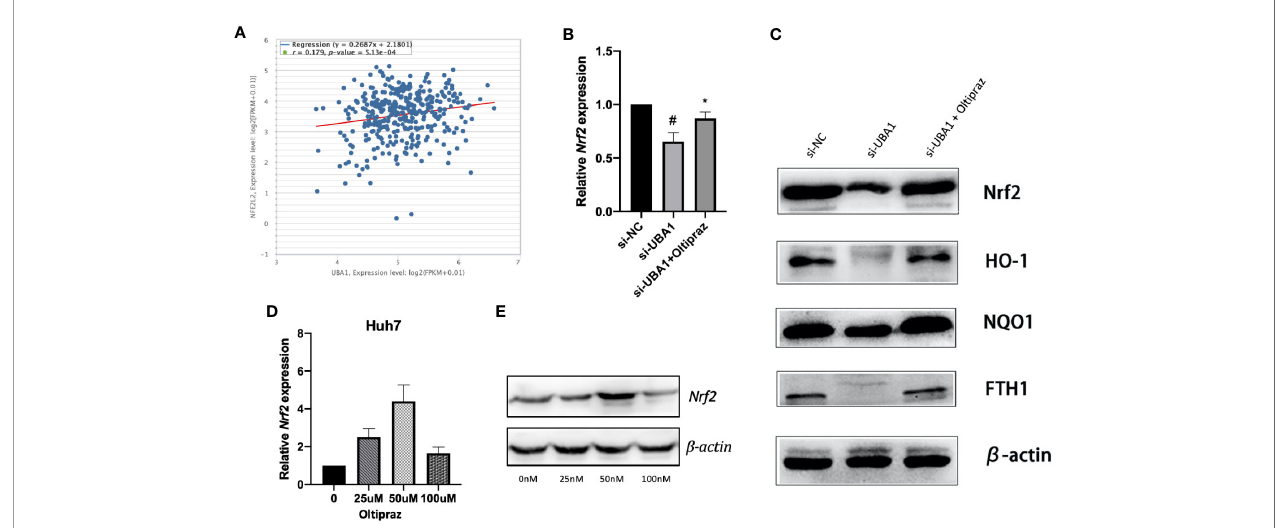
FIGURE 9 | The Nrf2 signal transduction pathway. (A) Coexpression correlation analysisin the TCGA HCC RNA-Seq cohort. (B) Following UBA1 silencing, Nrf2 expression, alongwith the downstream members( HO-1 , NQO1 , and FTH1 ) (C) , was downregulated,as evidenced byWestern blotting. (D, E) Best oltipraz dose screening. * p < 0.01, # p <